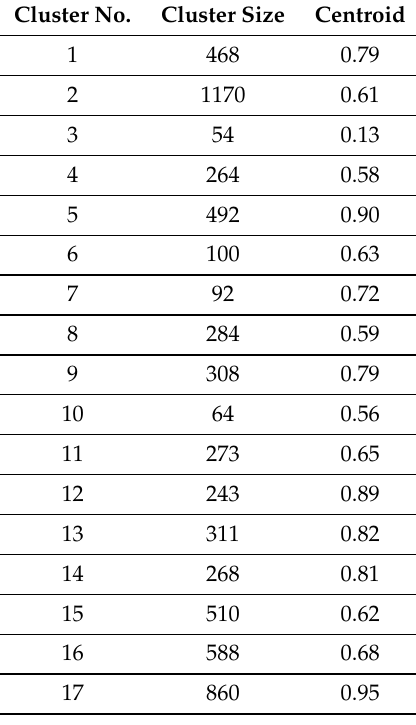
Table 2. The malware clusters for k = 17.